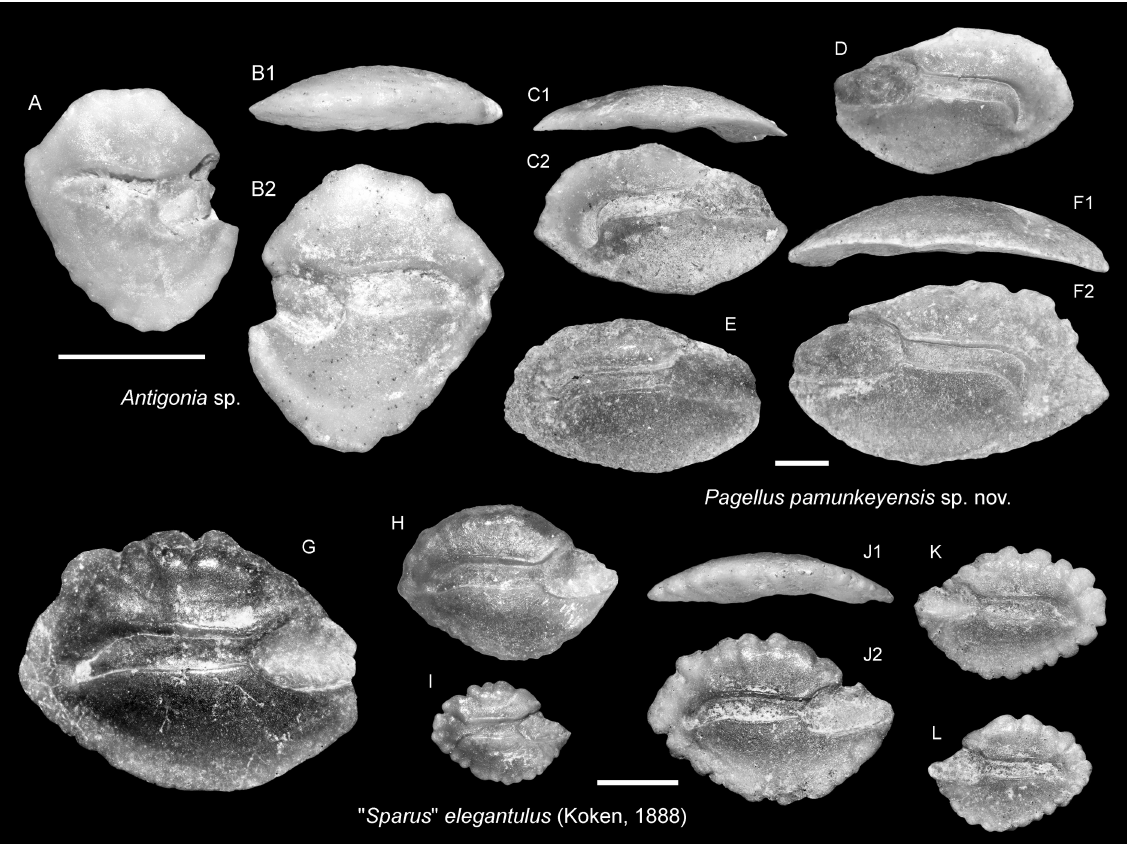
Fig. 36. Fish otoliths from the US middle and upper Eocene. A–B . Antigonia sp., Piney Point F.,